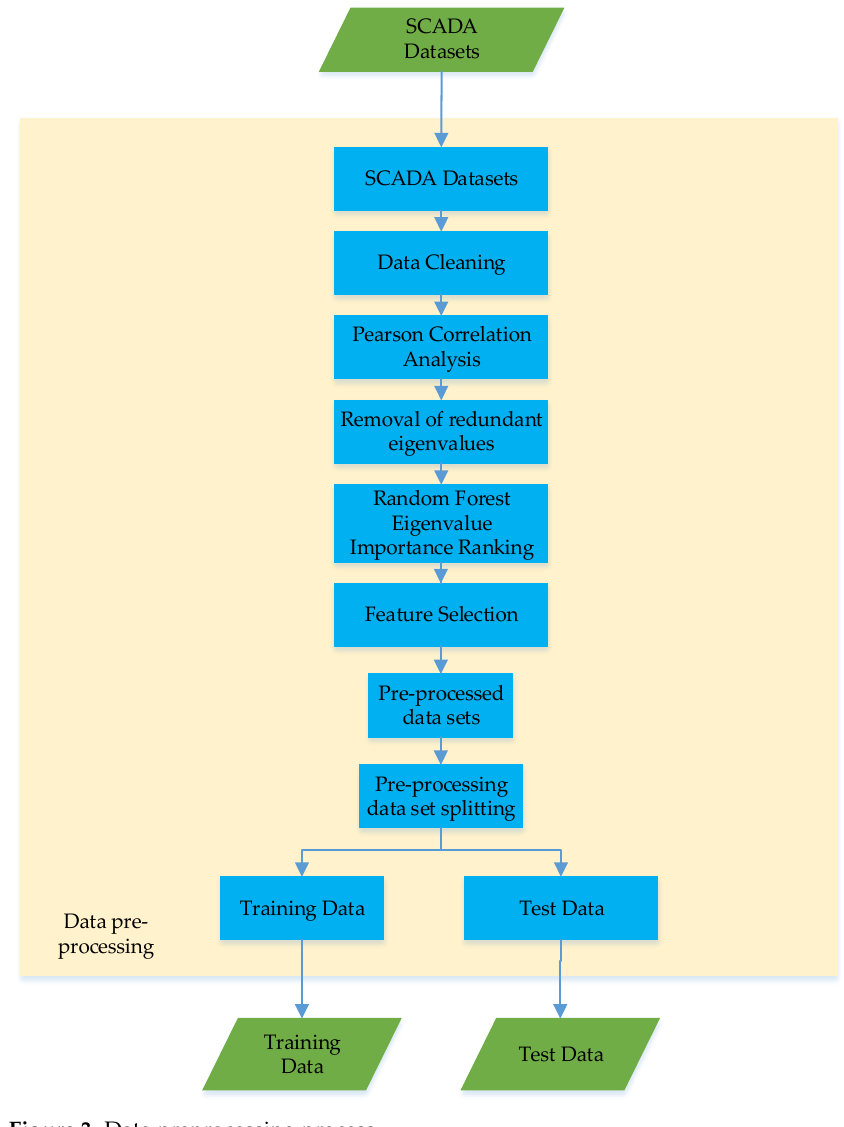
Figure 3. Data preprocessing process.